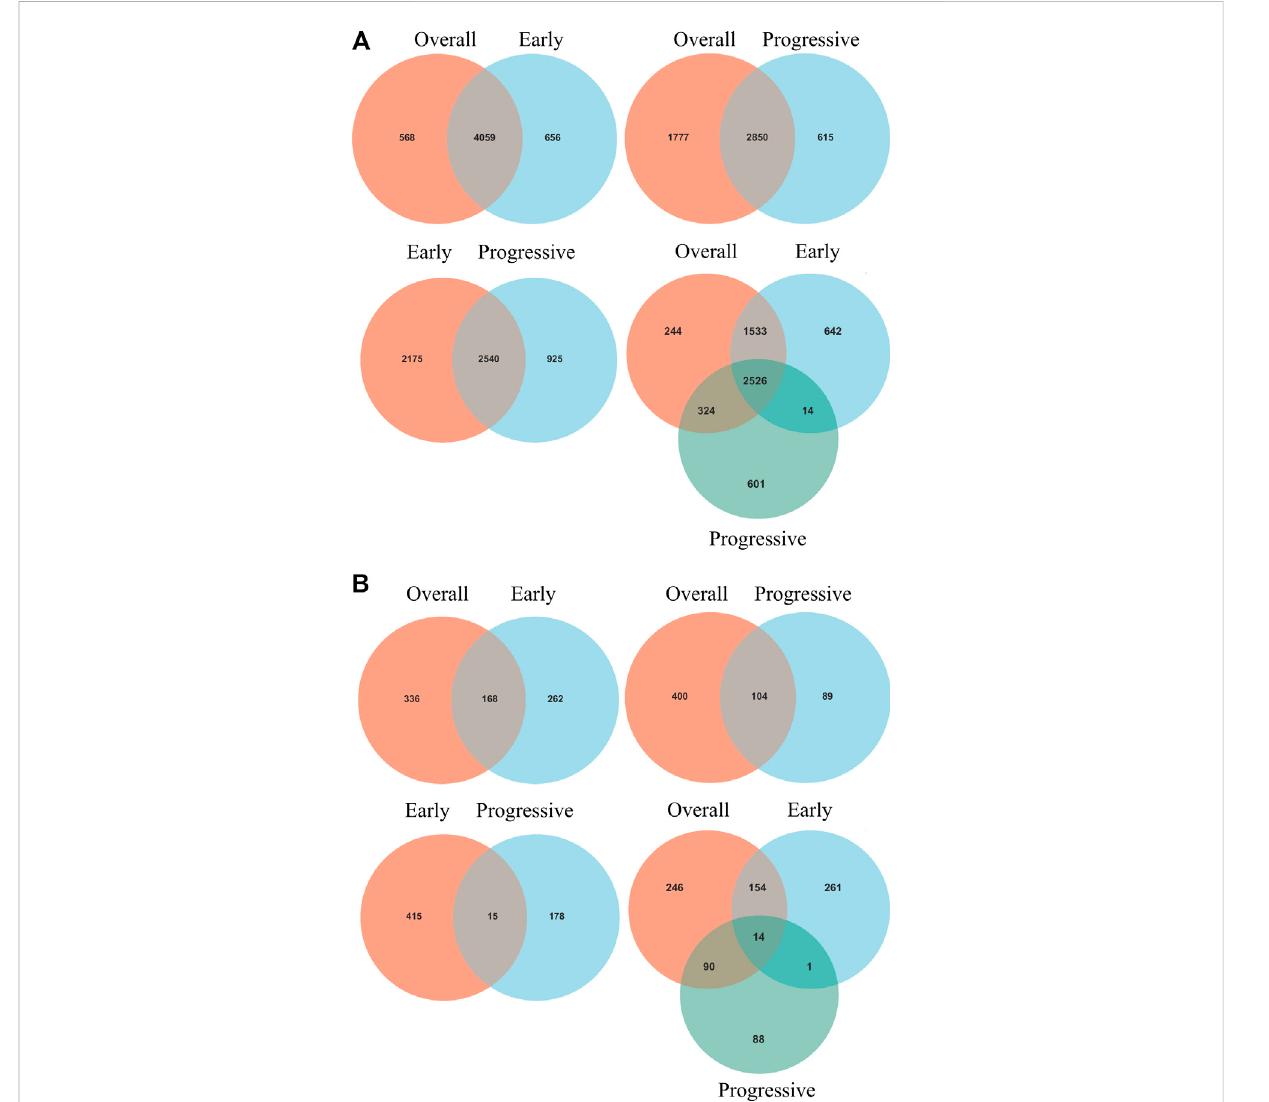
FIGURE 3 Venn diagrams of overlapping DEGs and mRNAs-OS from overall-, early-, and progressive-stage STAD. Venn diagrams are shown for overlapping DEGs (A) or mRNAs-OS (B) . Terms over the circles represent the groups of DEGs or mRNAs-OS at different stages of